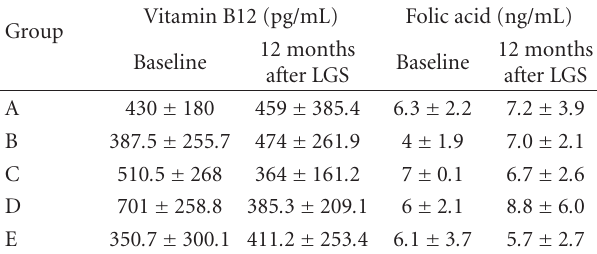
Table 4: Vitamin B12 and folic acid before and after surgery.